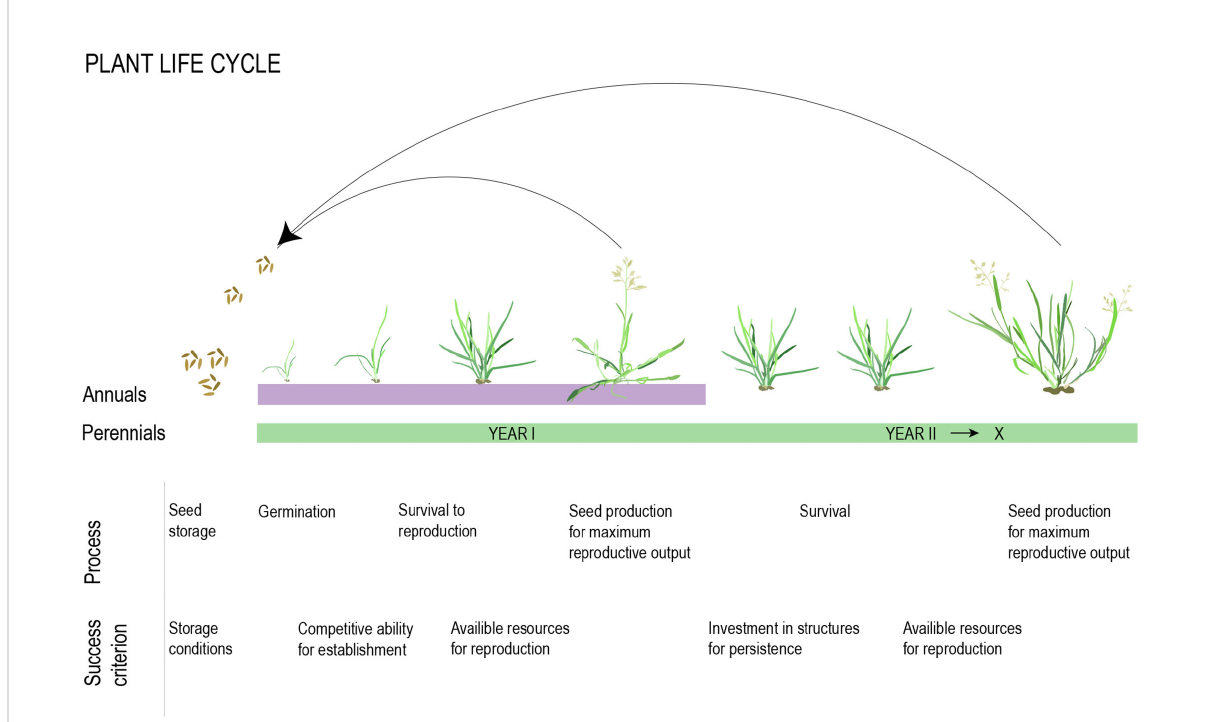
FIGURE 2 Developmental and physiological processes in fl uencing reproductive output in annual and perennial taxa. The total outcome is determined by resources available for allocation to these processes and the trade-offs between